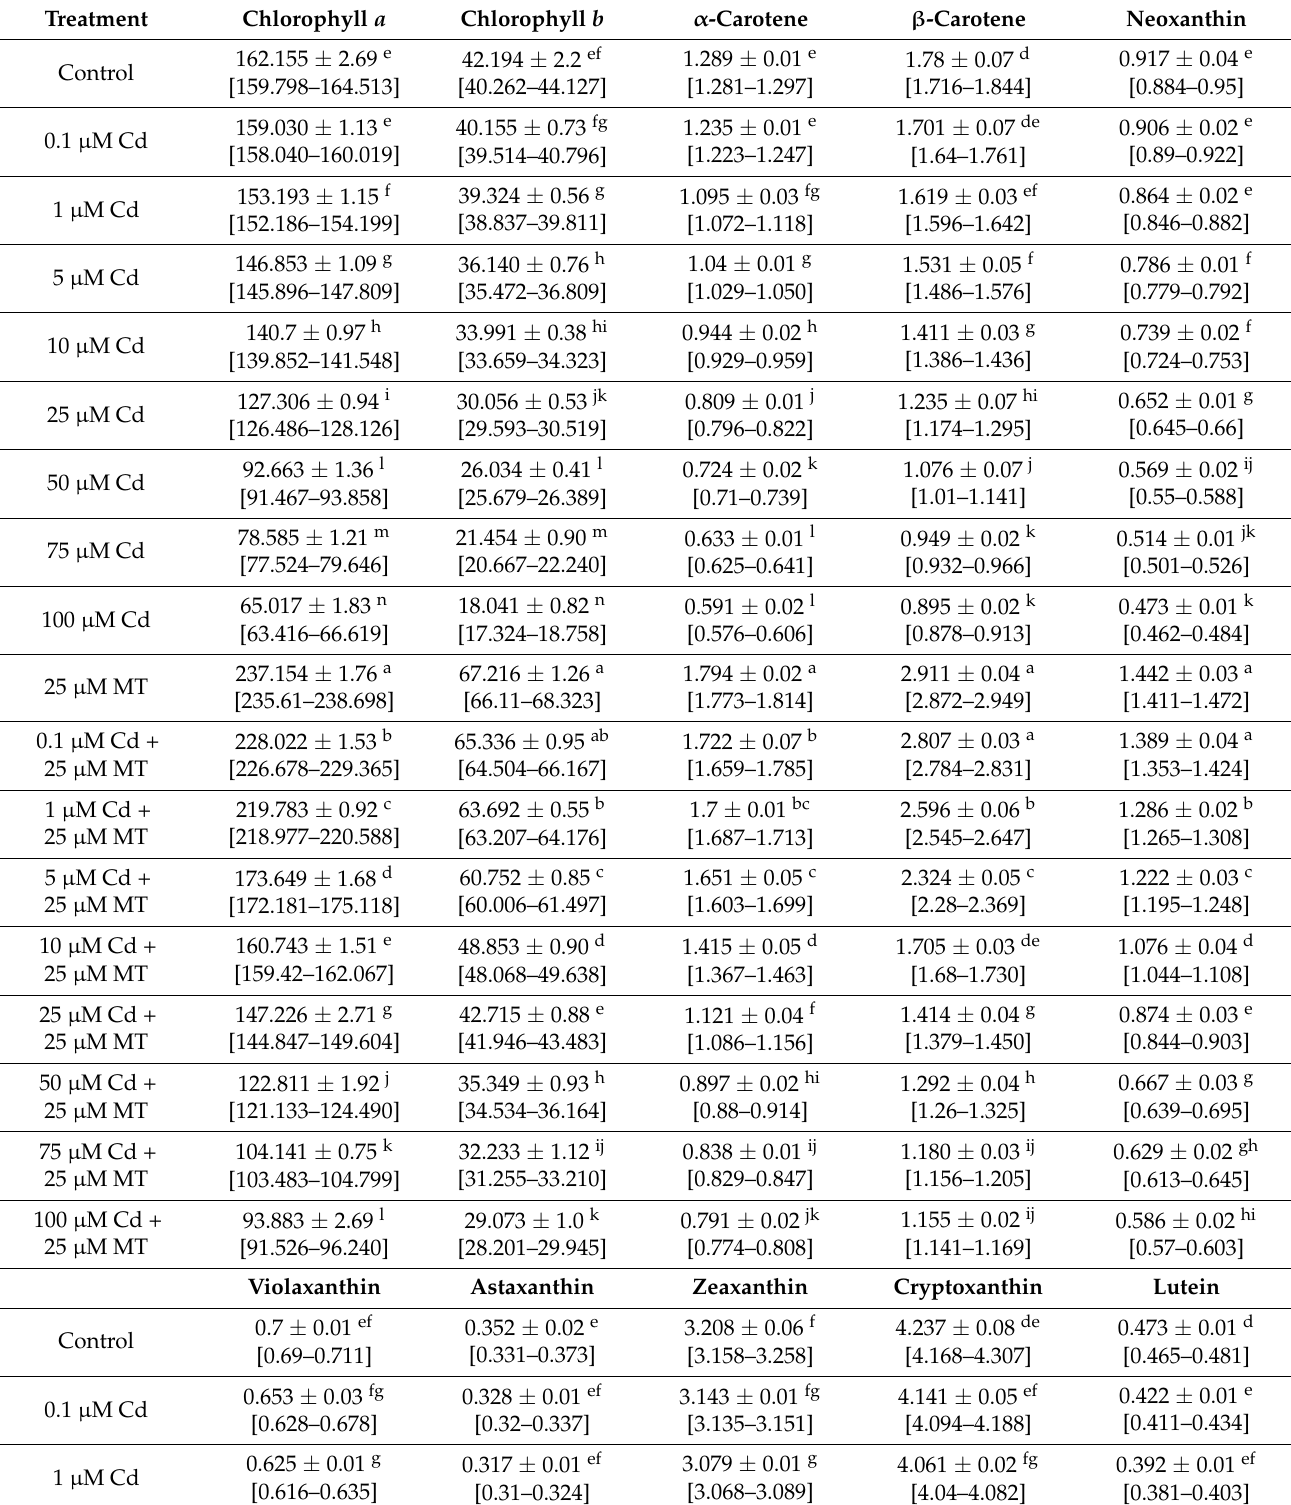
Table 3. The endogenous level of photosynthetic pigments ( µ g/ g fresh weight) in W. arrhiza exposed to cadmium (Cd) or/with melatonin (MT) after 7 days of cultivation. The results present the mean ( n = 5, biological replicate) ± standard deviation. The range in square brackets corresponds to the 95% confidence interval of the means. Means with the same letters are not significantly different ( p ≥ 0.05) according to Tukey’s post hoc